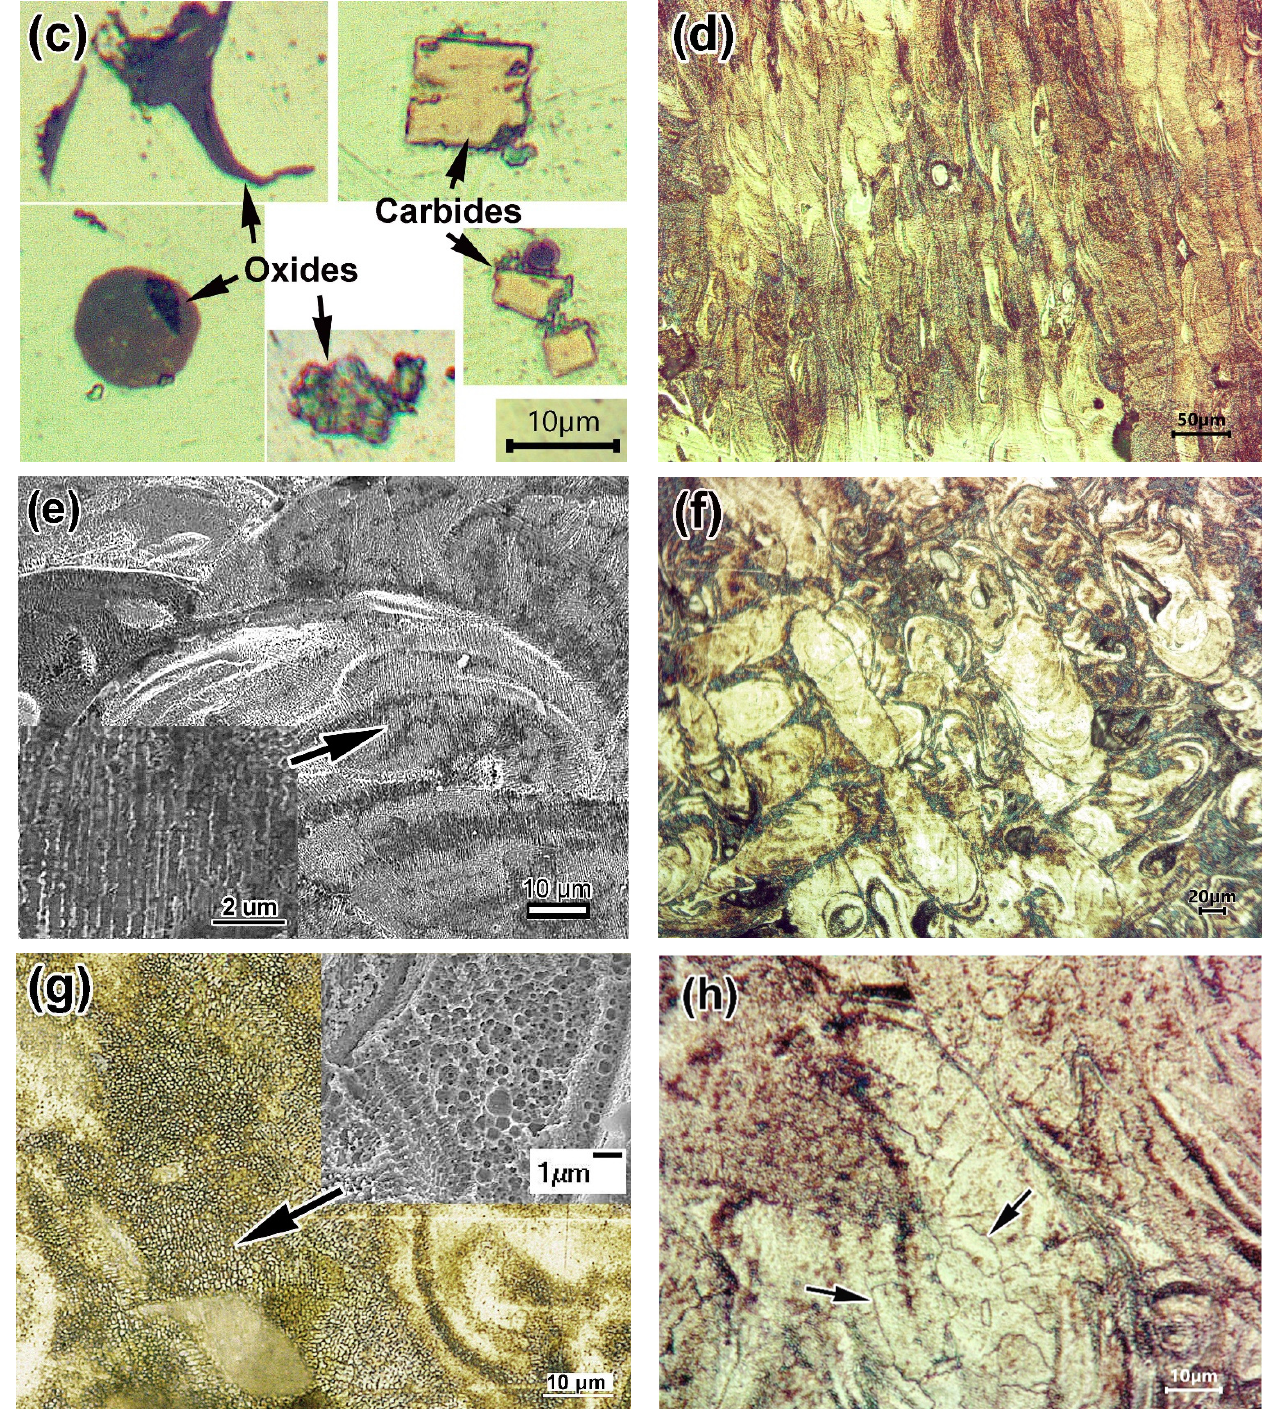
Figure 1. Microstructural features of the as-received specimens: ( a ) plate 316T, ( b ) non-etched LPBF 316L, ( c – h ) etched LPBF 316L. LPBF